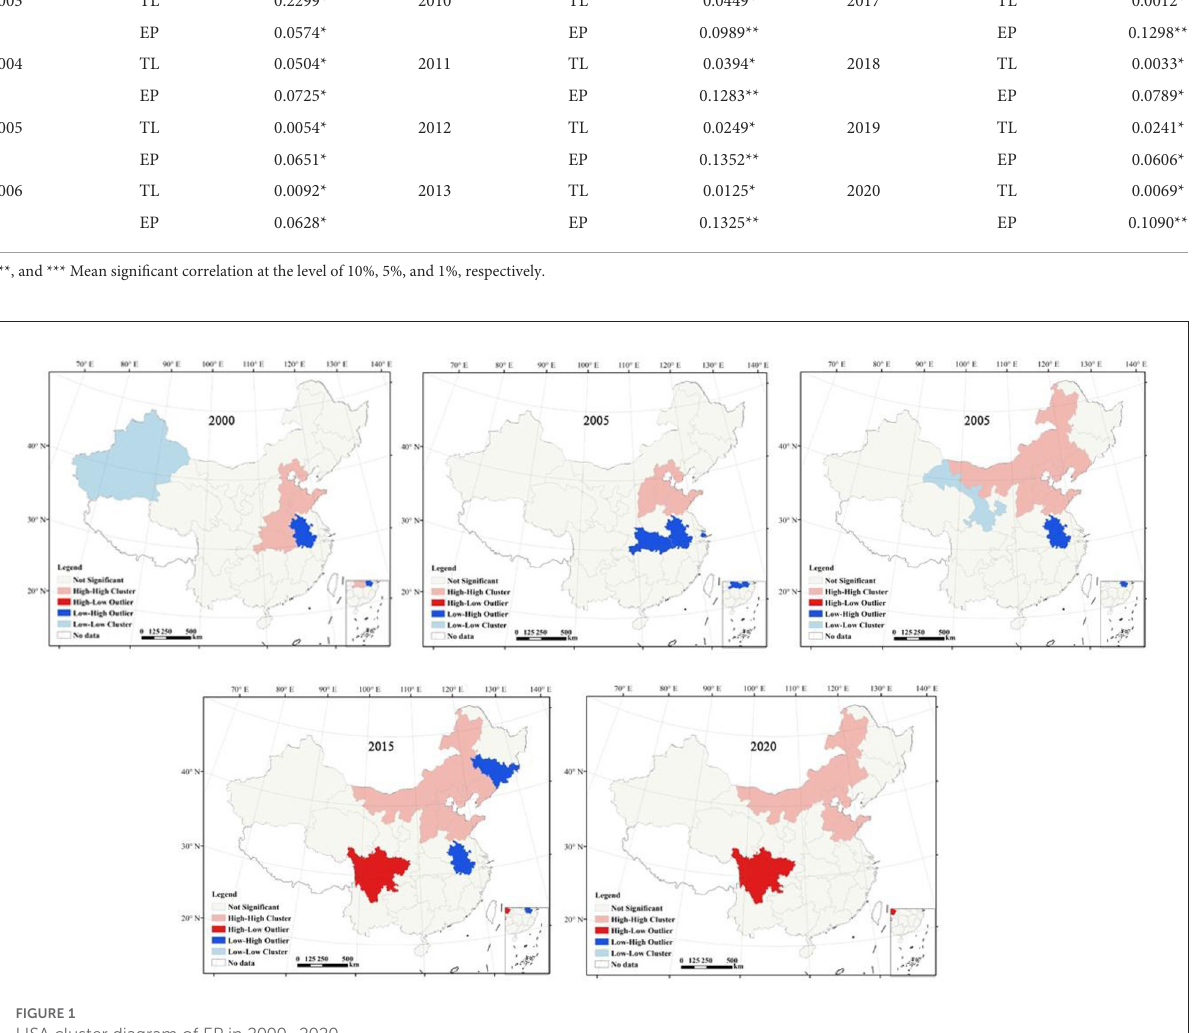
(Environmental Systems Research Institute), as listed in Table 4 and Figure 2. The results show that the following: (1) the standard deviation ellipse was generally positioned in the eastern China. The circumference of the ellipse showed a “first increasing and then decreasing” trend; it increased from 58.23 km in 2000 to 63.87 km in 2015 and then decreased to 63.77 km in 2020.